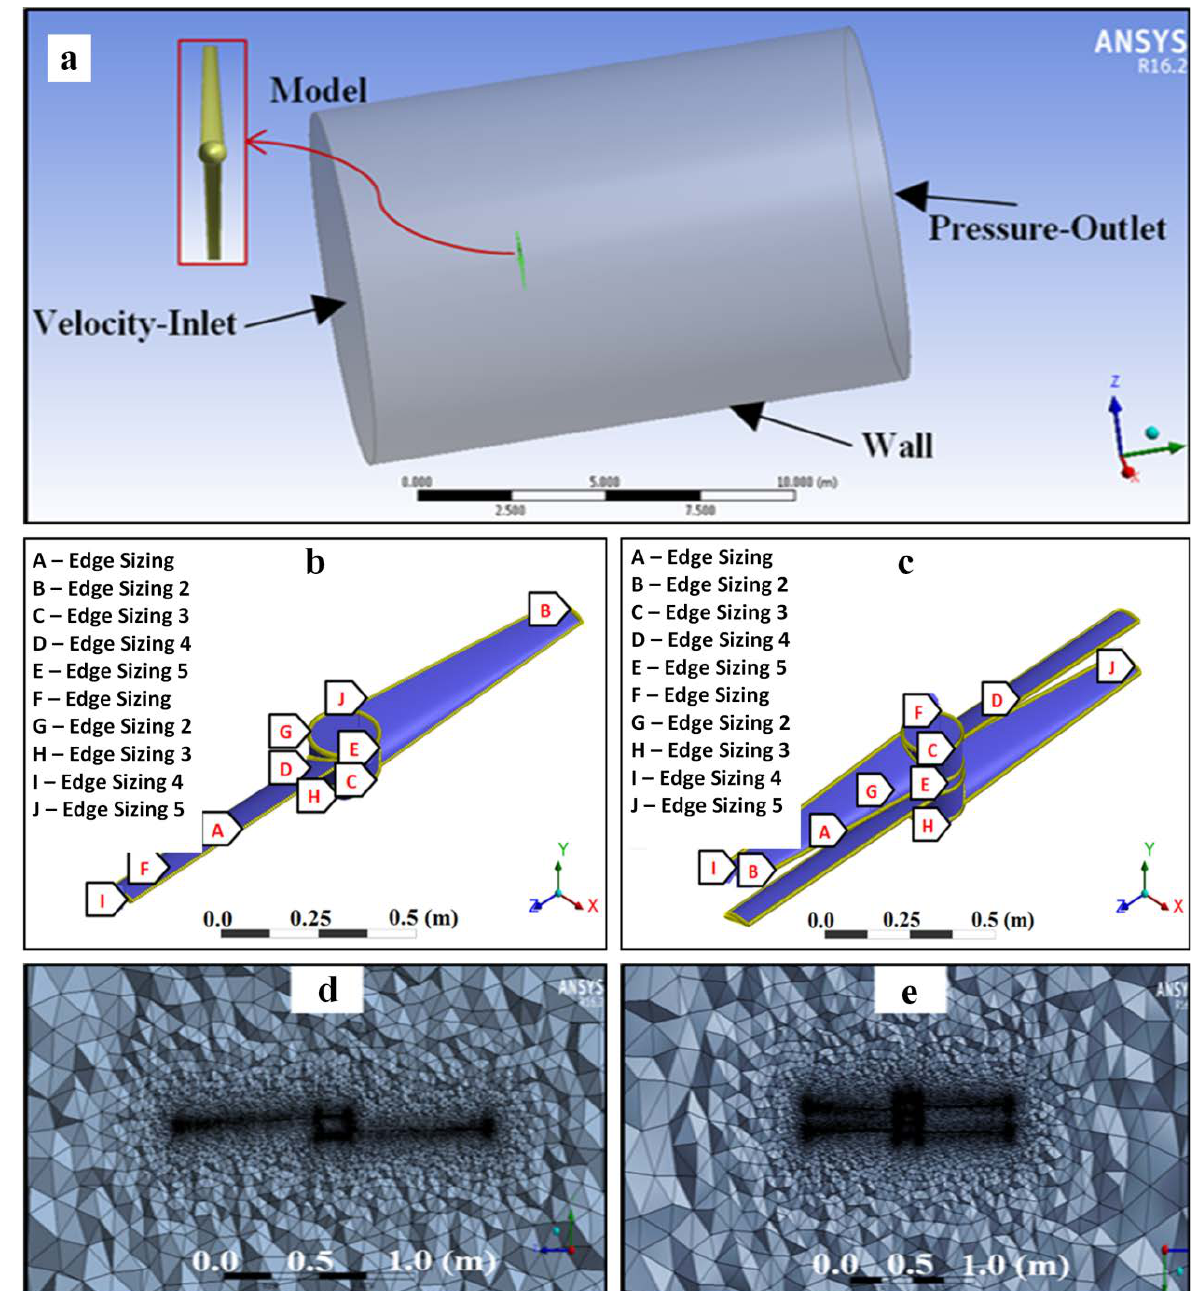
Figure 4. ( a ) Boundary condition; geometry with mesh sizing at edge location for ( b ) SRRAT and ( c ) CRRAT; and structure of saturated, fine, and coarse mesh for ( d ) SSRAT and ( e ) CRRAT.